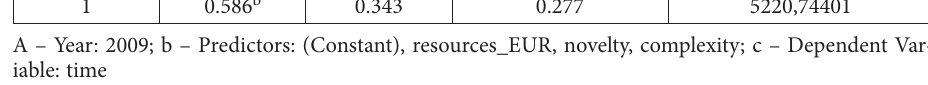
Table 11. Summary of Regression Model Model R R Square Adjusted R Square Std. Error of the